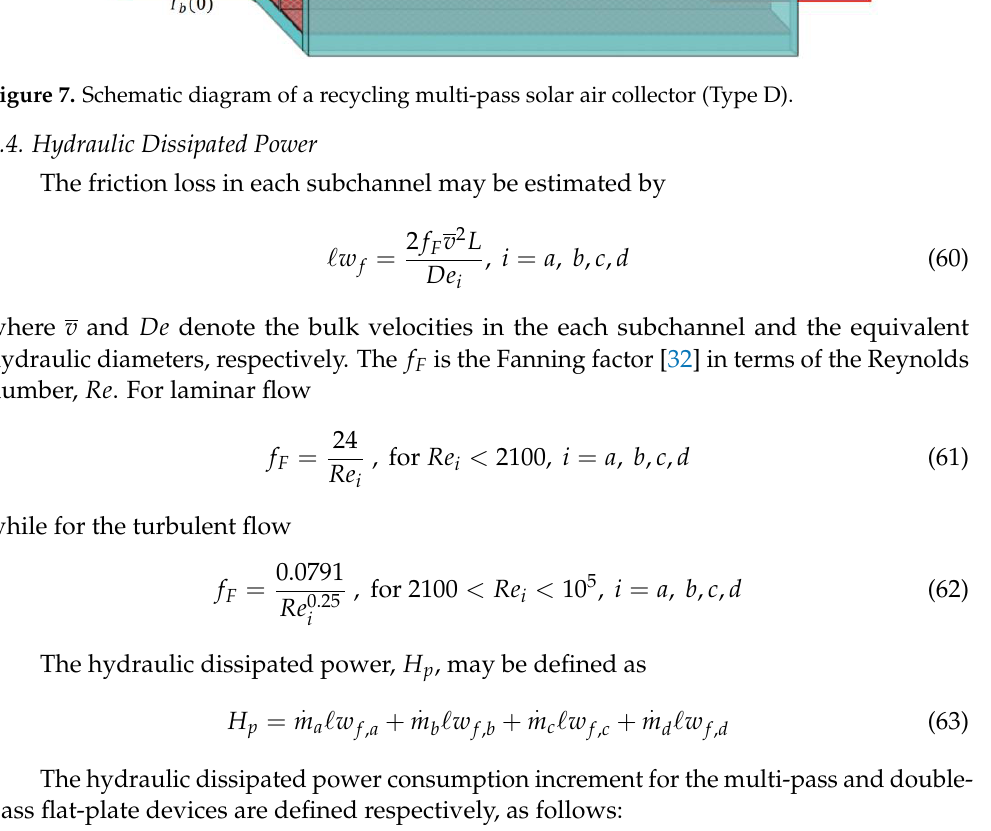
Figure 7. Schematic diagram of a recycling multi-pass solar air collector (Type D).